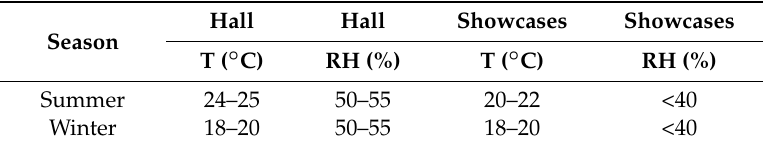
Table 1. Thermo-hygrometric recommended values for the conservation of